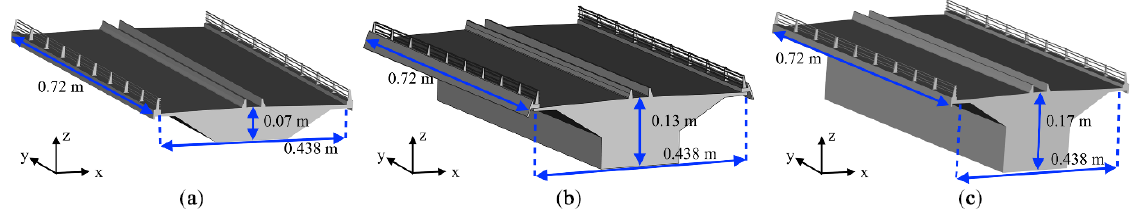
Figure 4. Dimensions of bridge deck models: ( a ) Geometry of the shallow deck; ( b ) Geometry of the medium deck; ( c ) Geometry of the deep deck.